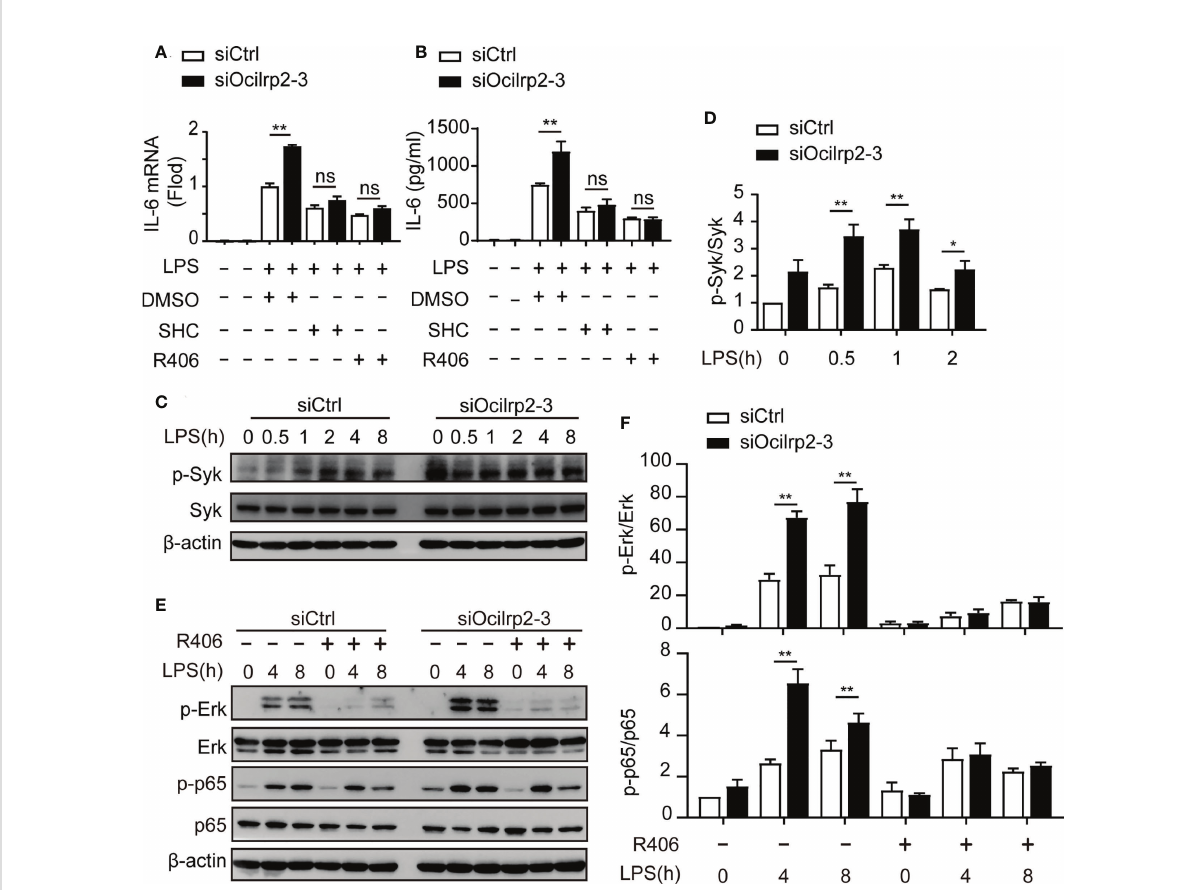
siOcilrp2 and then incubated with or without LPS for the indicated times. Immunoblot analysis of phosphorylated (p-) or total proteins of Syk, the expression of b -actin was used as a loading control; (D) densitometric quanti fi cation of the ratio of p-Syk to total-Syk; Data were analyzed by three independent experiments. (E) Peritoneal macrophages were transfected with siCtrl or siOcilrp2-3 for 48 h and pretreated with Syk inhibitors (R406) for 1 h, then stimulated with or without LPS for the indicated times. Cells extracts were immunoblotted with phosphorylated (p-) or total proteins of Erk and p65 antibodies. The expression of b -actin was used as a loading control. (F) densitometric quanti fi cation of the ratio of p-Erk to total-Erk and p-p65 to total p65. Data are representative of the results of three independent experiments (means ± s.e.m). Signi fi cant differences compared to the control group are denoted by * P < 0.05, ** P < 0.01, ns: not signi fi cant (two-tailed Student ’ s